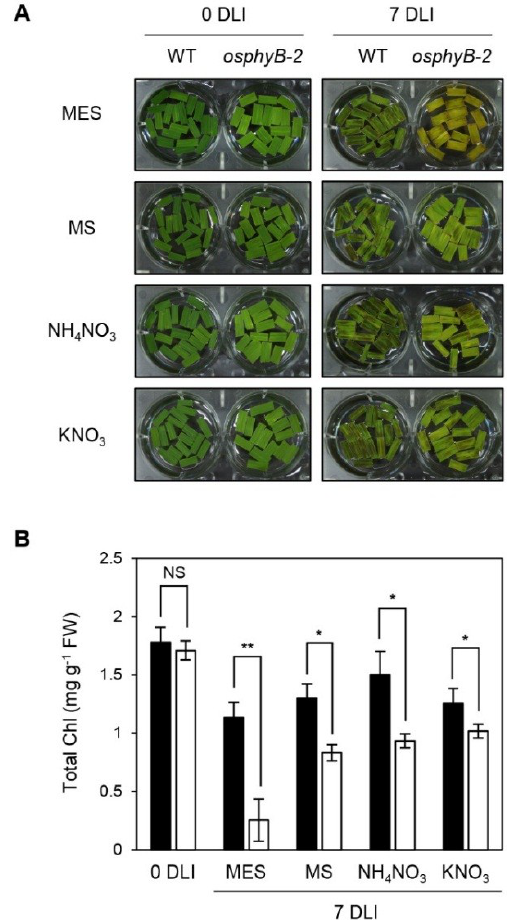
Figure 4. Early senescence phenotype of osphyB -2 was rescued by supplementation with nitrogen compounds. Detached leaf segments from one-month-old WT and osphyB-2 plants grown under LD conditions were transferred to the 3 mM MES (pH 5.8) buffer only or supplemented with MS (2.3 g/L), NH 4 KO 3 (1.65 g/L), or KNO 3 (1.9 g/L), and incubated with the abaxial side up at 28 °C under continuous light for 7 days. The changes of phenotype ( A ) and total Chl level ( B ) in the leaf segments of WT and osphyB-2 in each condition was observed and compared with the MES control; ( B ) Black and white bars indicate WT and osphyB-2 , respectively. Mean and SD values were obtained from more than five biological replicates. Asterisks indicate significant difference between WT and osphyB-2 (Student’s t -test p values, * p < 0.05; ** p < 0.01). NS, not significant; DLI, day(s) of light